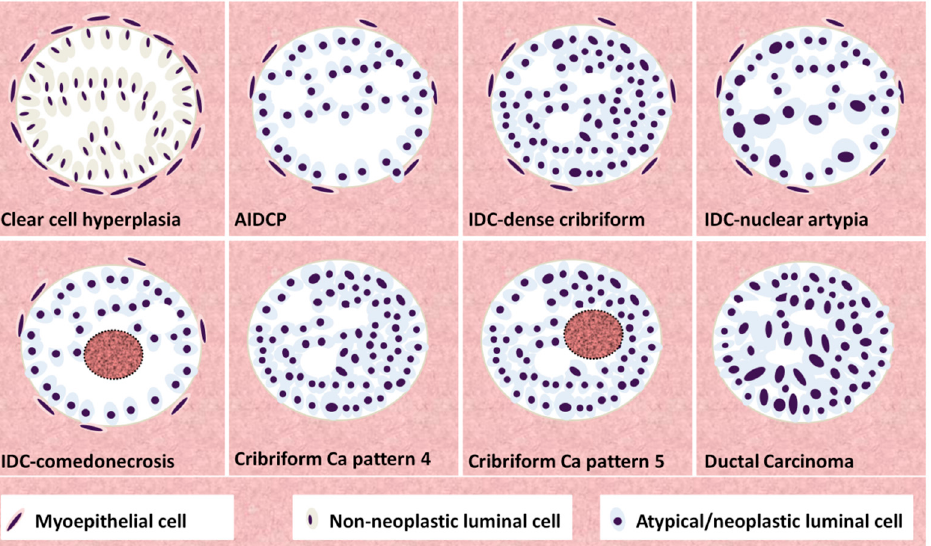
Figure 6. Graphical illustration of the various entities with cribriform morphology. Clear cell hyperplasia is characterized by a loose cribriform proliferation of clear cells without atypia. In atypical intraductal cribrifrom proliferation (AIDCP), atypical cells proliferate within a duct lumen (note the myoepithelial cells at the periphery); however, the architecture is loose, and the cells take up <50% of the surface of the lumen. In intraductal carcinomas (IDC), three patterns may be observed (alone or in combination): dense cribriform (>50% of the surface) or even solid (not shown) proliferation of atypical cells within the duct lumen (note the presence of myoepithelial cells, albeit they may be sparse in some cases) and loose architecture, but with either nuclear atypia or comedonecrosis. In cribriform carcinoma myoepithelial cells are missing (cribriform carcinoma is assigned a Gleason Grade 4). However, a Gleason Grade 5 is assigned if comedonecrosis is present (note again the lack of myoepithelial cells, consistent with invasive carcinoma). In ductal carcinoma, lumina are slit-like (instead of round) and cells are columnar. Myoepithelial cells are usually absent (although intraductal spread may be observed, not shown here).